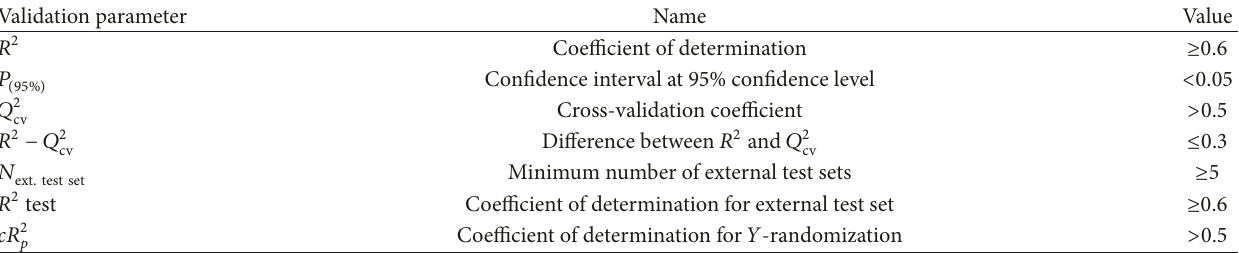
Table 2: Minimum recommended value of validation parameters for a generally acceptable QSAR